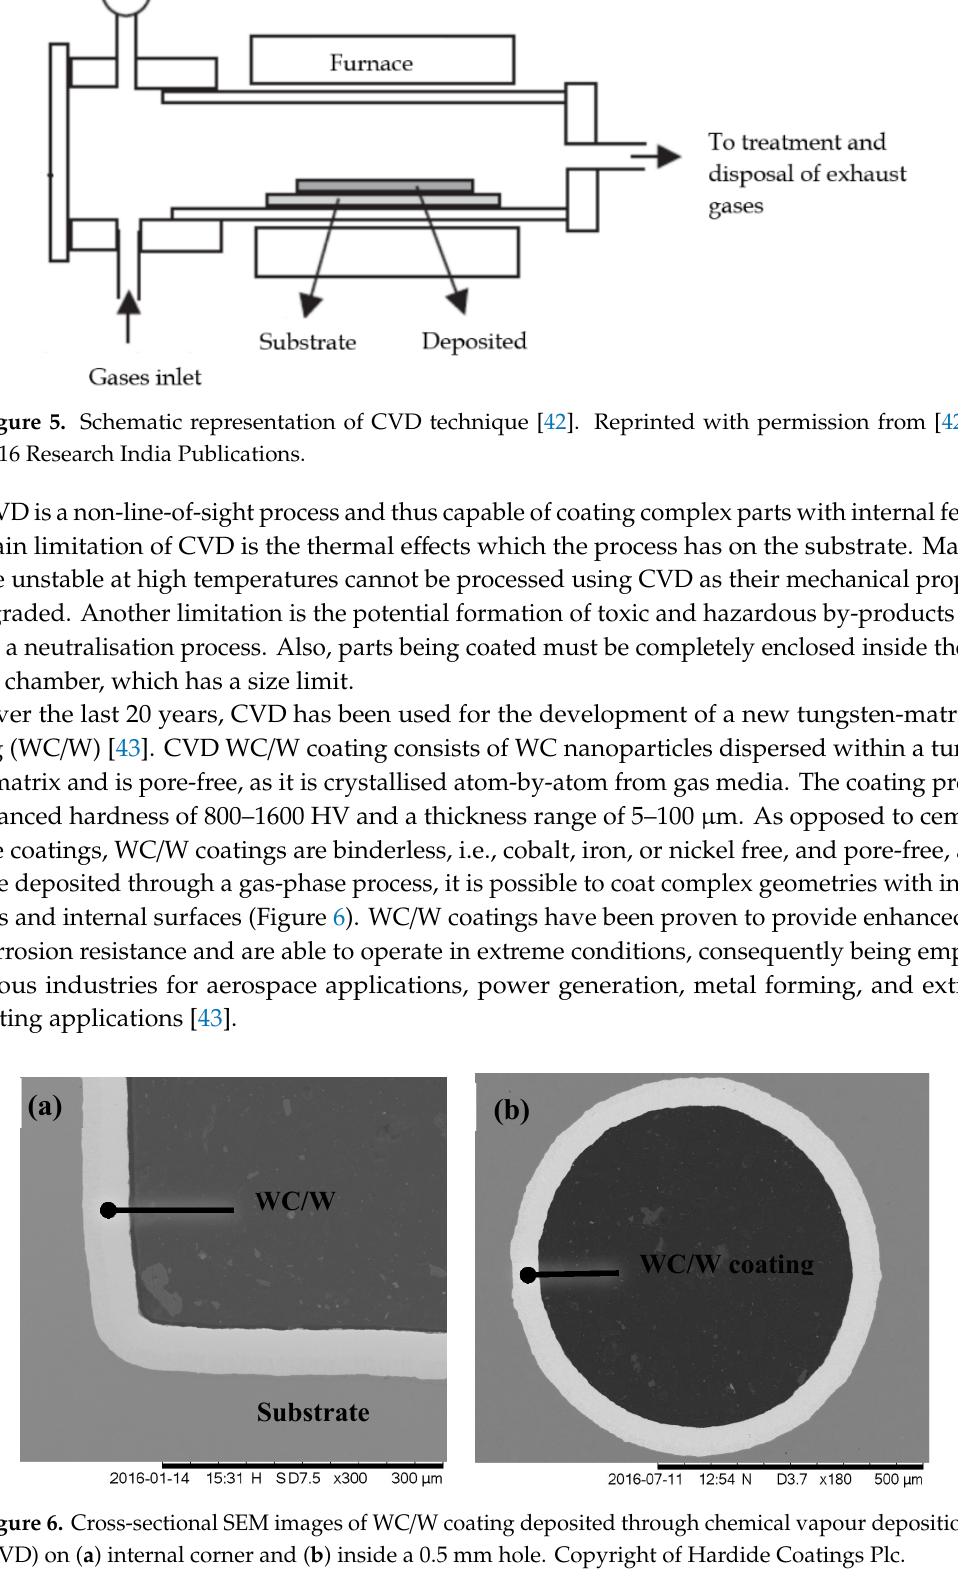
Figure 6. Cross-sectional SEM images of WC/W coating deposited through chemical vapour deposition (CVD) on ( a ) internal corner and ( b ) inside a 0.5 mm hole. Copyright of Hardide Coatings Plc.